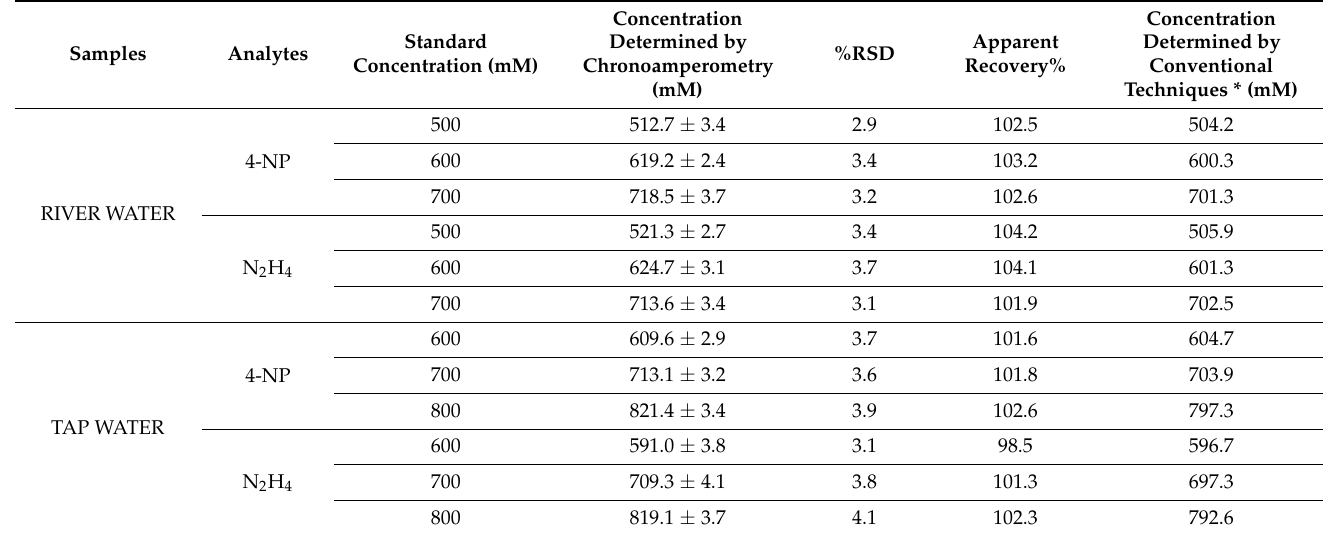
Table 2. Quantification of N 2 H 4 and 4-NP in river and tap water samples. (*) refers to the HPLC analysis of N 2 H 4 and